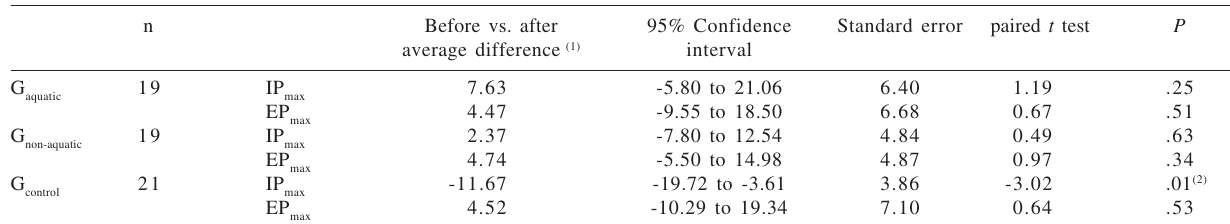
Table 3 - Comparison of the IP t